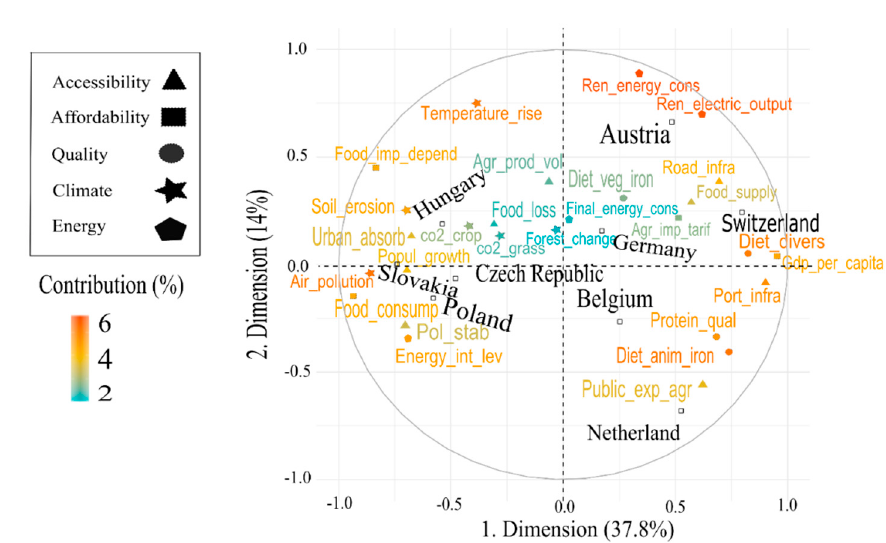
Figure 2. Individual blocks (grand challenges) and the contributions (%) of each indicator in the Central European (CE) countries to the first two dimensions (principal components).